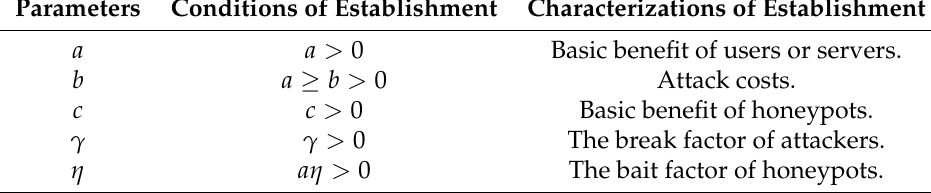
Table 2. List of revenue